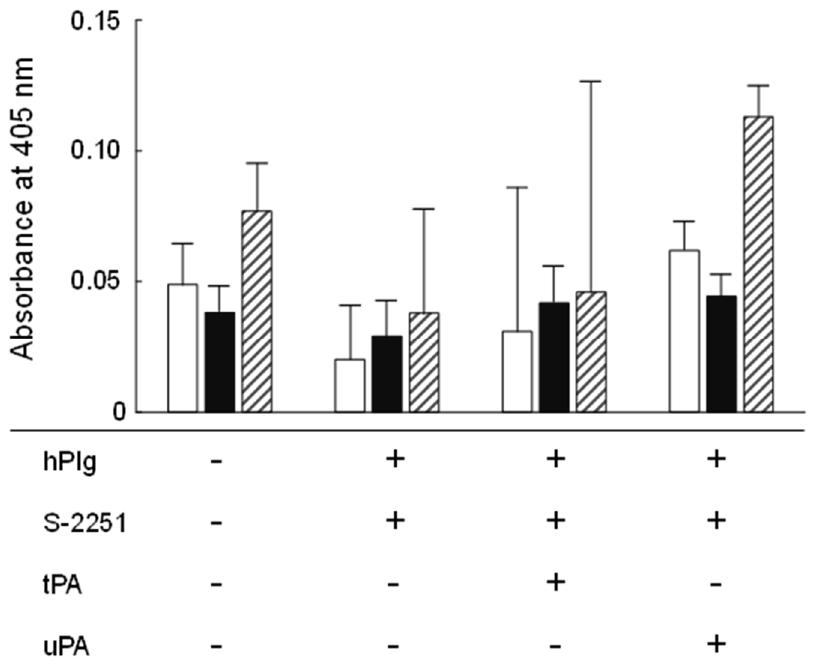
Figure 5. Plasminogen binding and activation activities of YM2-1 and YM2-3 strains. The experiment was performed in three independent trials, and then obtained data were statistically analyzed using one-way ANOVA with Tukey’s post hoc test. Data were considered significant at a p value less than 0.05. Consequently, no significant difference was found in the activities among YM2-1, YM2-3, and LGG under different experimental conditions. hPlg, human plasminogen; S-2251, 0.54 mM D -valyl-leucyl-lysine- p -nitroanilide dihydrochloride; tPA, 0.24 KIU tissue plasminogen activator; uPA, 0.06 KIU urokinase plasminogen activator.